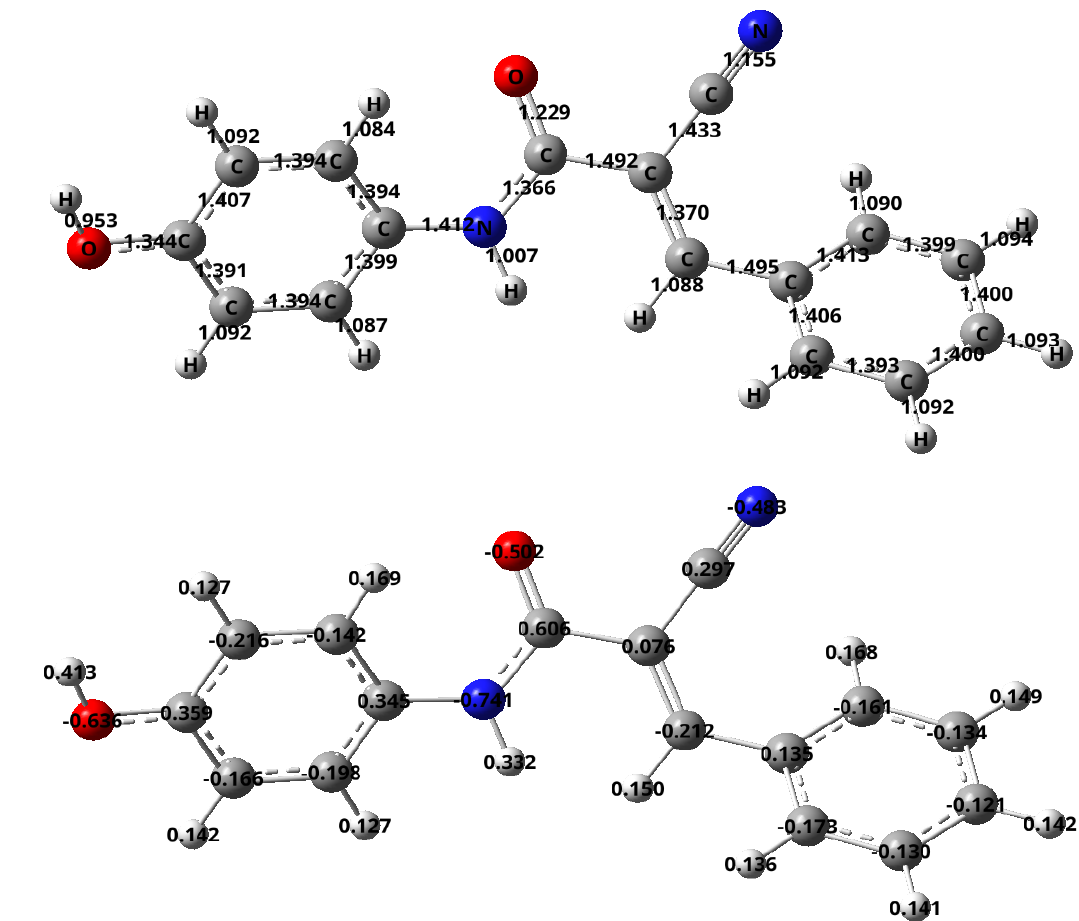
Figure 16. Bond distances, Mulliken atomic charges, HOMOs, and LUMOs, of compounds ACR-2 and ACR-3.